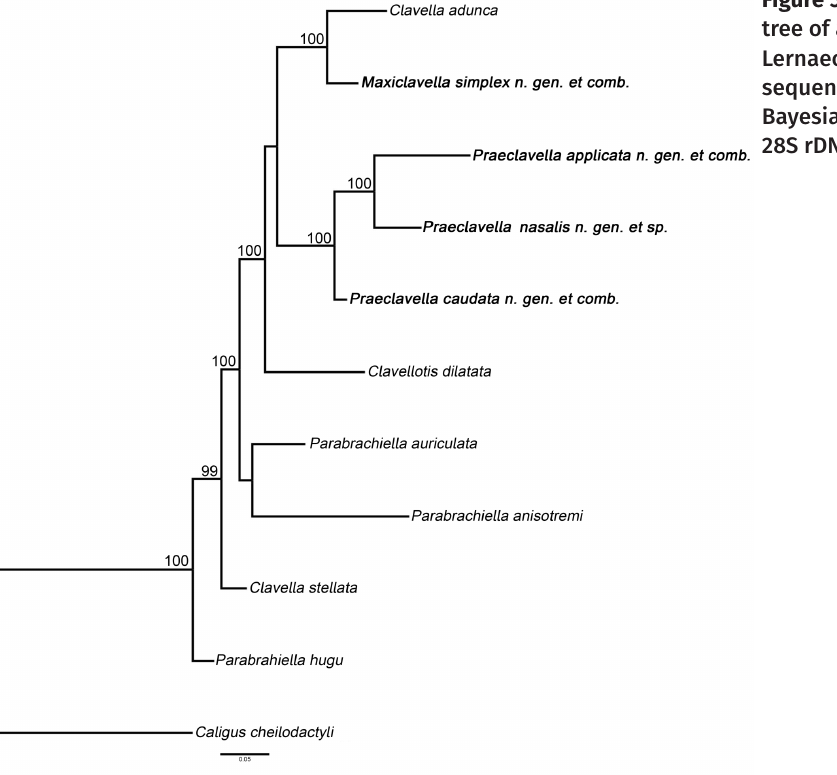
Figure 5. Phylogenetic tree of all the available Lernaeopodidae family sequences constructed with Bayesian inference analysis of 28S rDNA